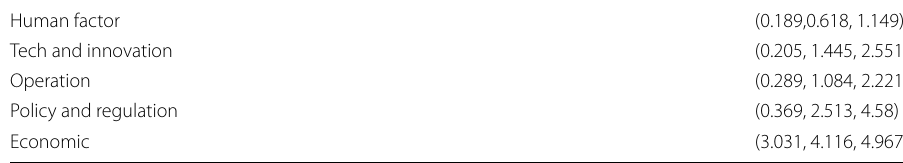
Table 12 Value of fuzzy weights (w